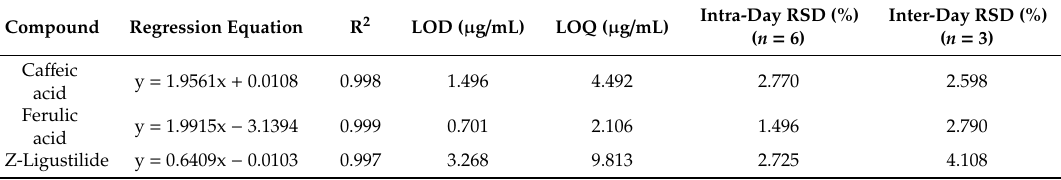
Table 2. Calibration curves, detection limits and quantification limits (n = 6) of the three chemical markers in Danggui by UPLC-PDA.